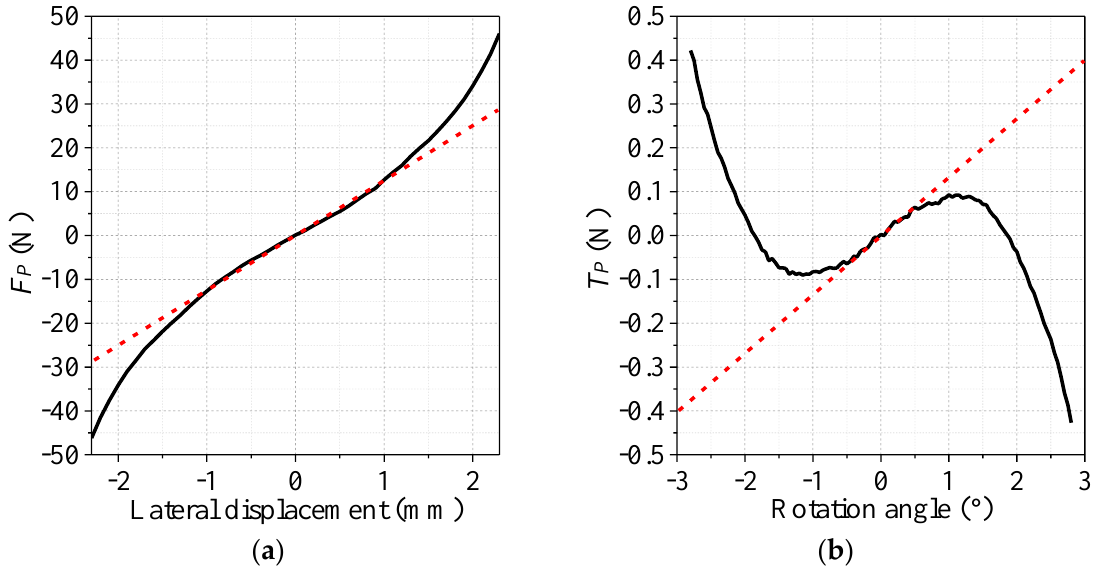
Figure 8. FEM analysis results of the four attractive-type permanent magnetic bearings: ( a ) Analysis result of F P ( b ) Analysis result of T P . Table 3. Main parameters of the plant model.